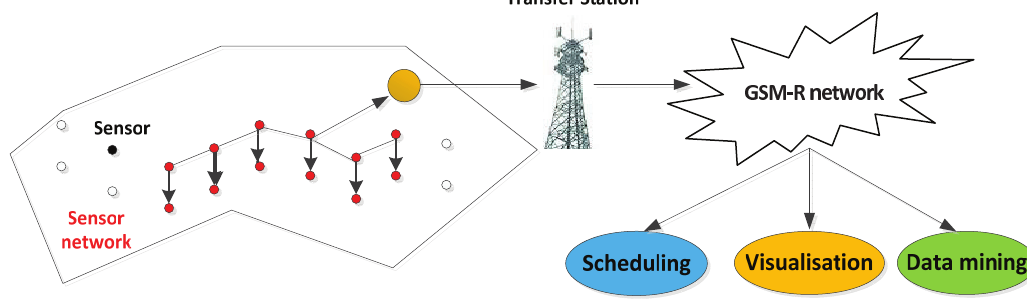
Figure 1: Framework of transmitting data in the sensor